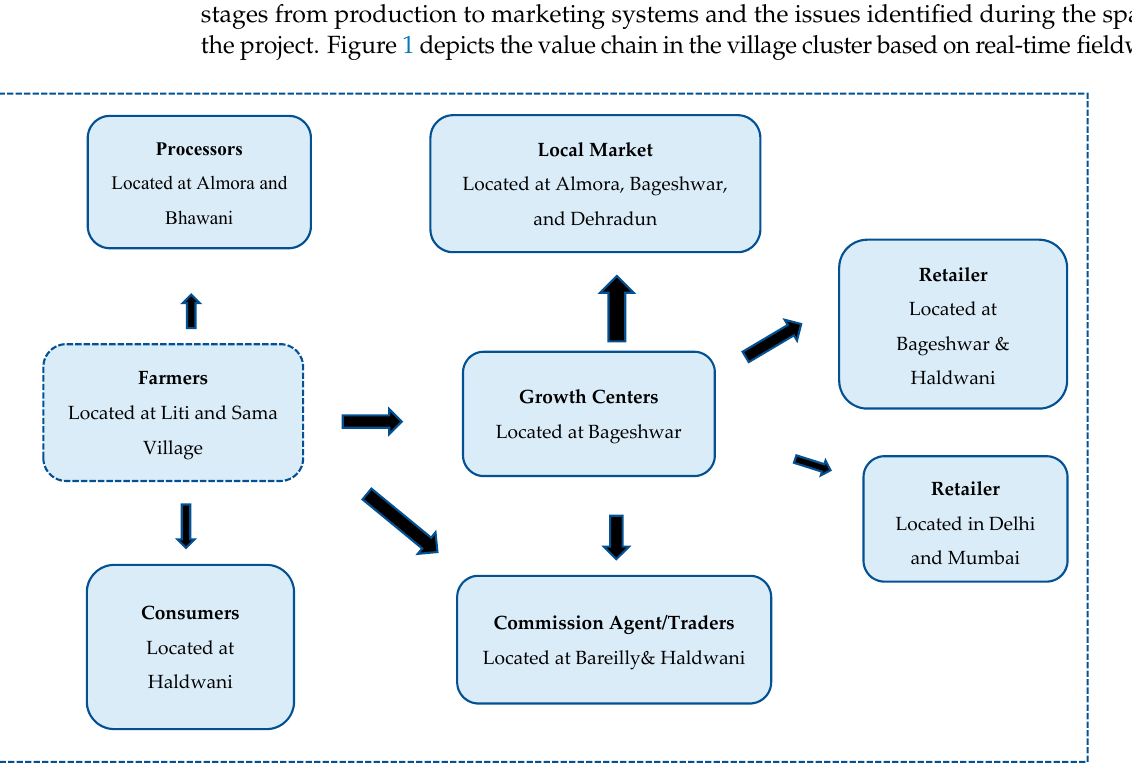
Fig. 1. Schematic diagram showing the traditional Kiwi value chain in Bageshwar